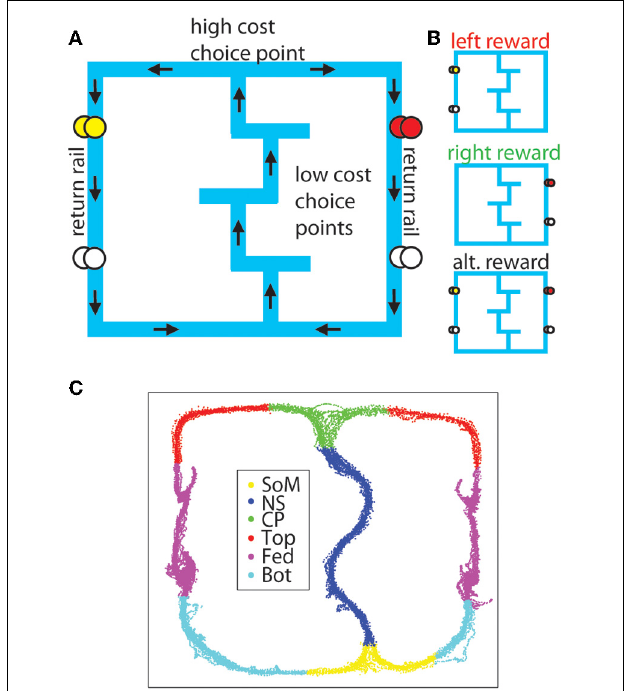
FIGURE 1 | The MT-LRA task. (A) The task consists of a central track containing three low-cost T-choices, a high-cost T-choice at the top of the central track, and two return-rails on which reward was delivered under either leftward , rightward , or alternating contingencies. The first reward site on the left side provided banana-flavored food pellets, while the first reward site on the right side provided fruit-flavored food pellets. The second reward site on both sides provided unflavored (white) food pellets. (B) Reward was only delivered if the animal made the correct choice under the active contingency. (C) For analysis, the maze was divided into six sections (SoM, start of maze; NS, navigation sequence ; CP, choice point; Top, top rails; Fed, feeder sites; Bot, bottom